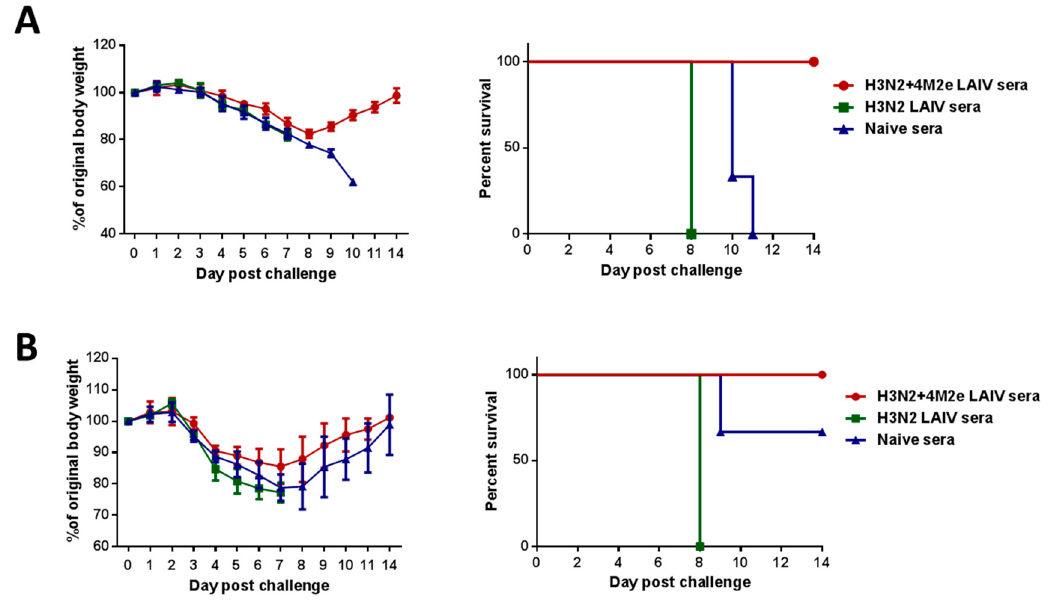
Figure 4. Passive protection by immune sera against challenge with heterologous A / Philippines / 2 / 82 (H3N2) virus ( A ) and A / Vietnam / 1203 / 04-PR8 (rgH5N1) virus ( B ). The left panel shows dynamics of body weight change; the right panel shows survival rates.